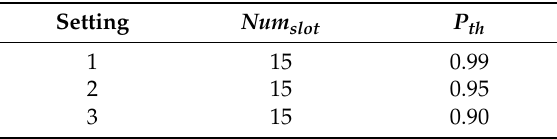
Table 6. Parameter settings with (cid:1840)(cid:1873)(cid:1865) (cid:3046)(cid:3039)(cid:3042)(cid:3047) as variable. Table 7. Parameter settings with P trans as